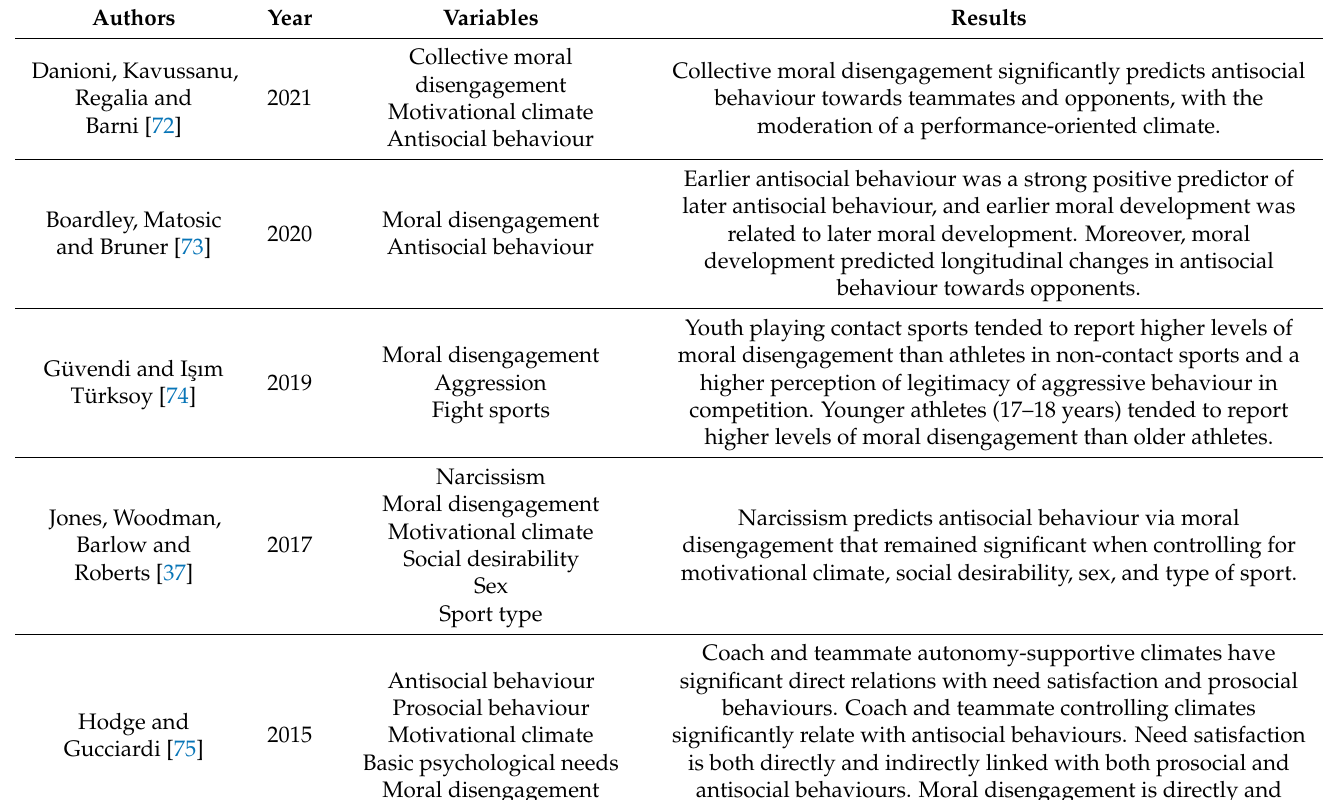
Table 2. Studies on moral disengagement as predictor of antisocial behaviour published between 2012 and